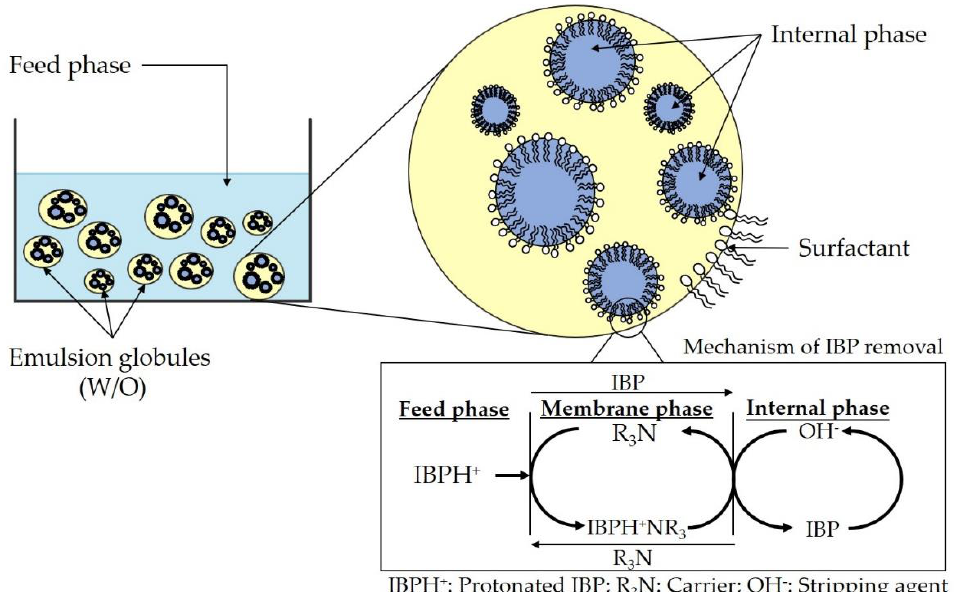
Figure 1. ELM mechanism for pollutant removal.